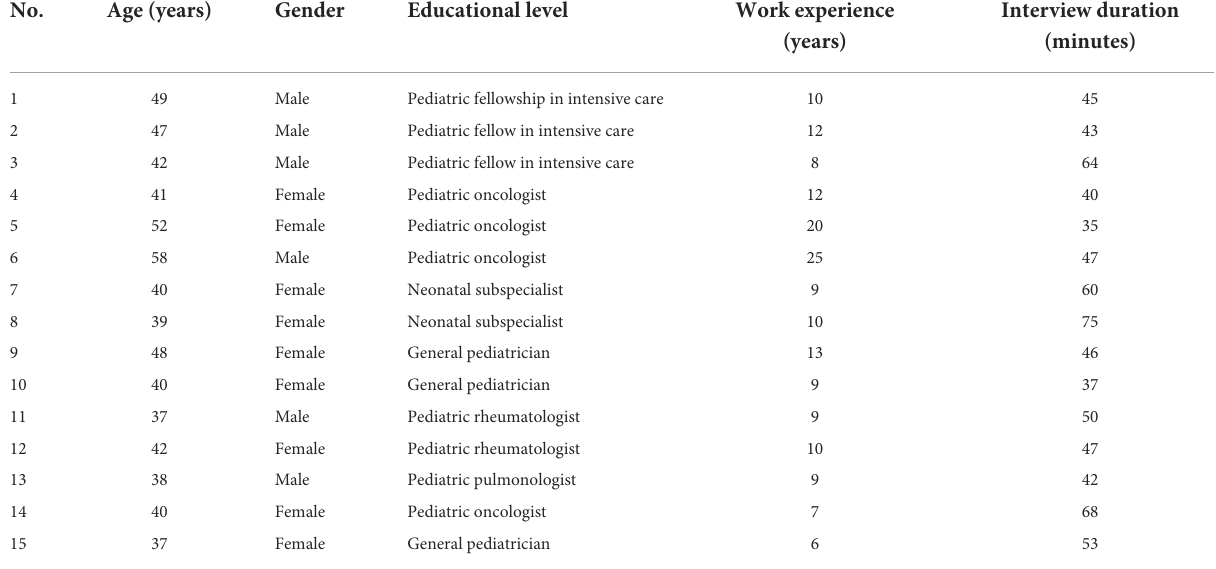
TABLE 3 Participants’